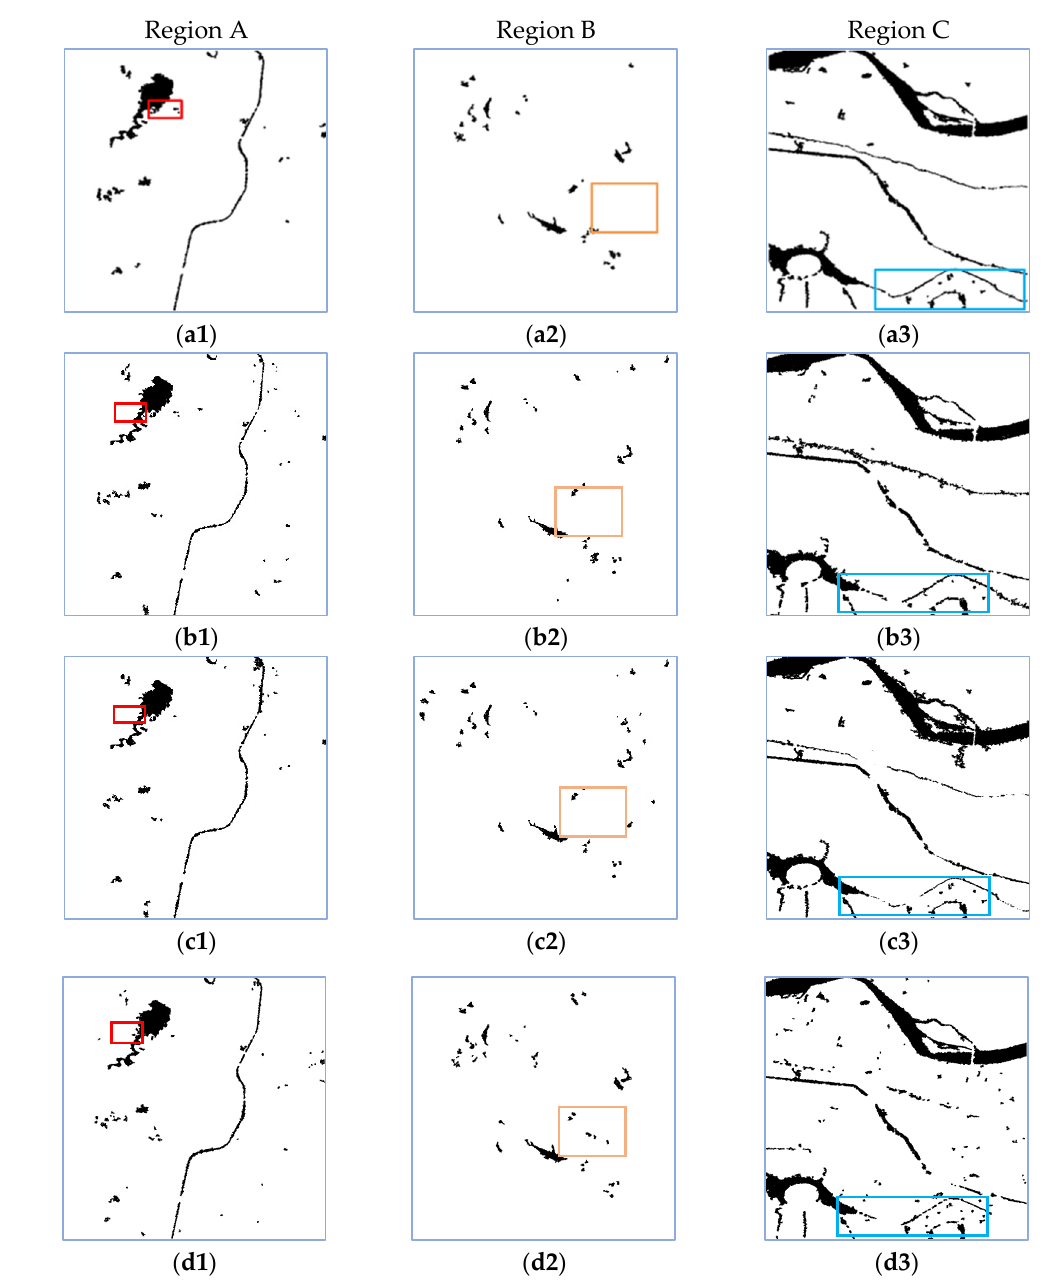
Figure 12. The extraction results of different strategies. ( a1 )–( a3 ) Strategy A. ( b1 )–( b3 ) Strategy B. ( c1 )–( c3 ) Strategy C. ( d1 )–( d3 ) Strategy D. Table 11. Quantitative evaluation of different strategies for the ablation study.